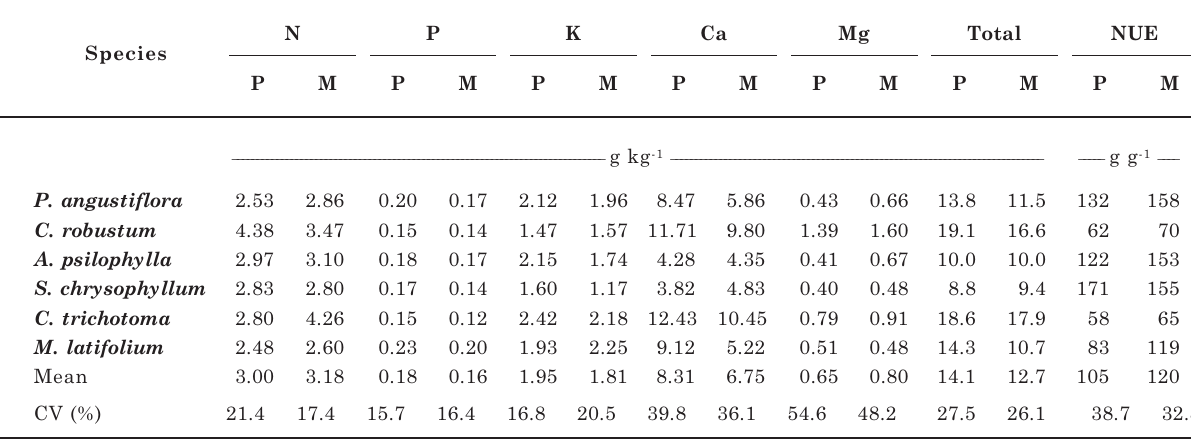
Table 5. Weighted average nutrient concentration in above-ground biomass and nutrient use